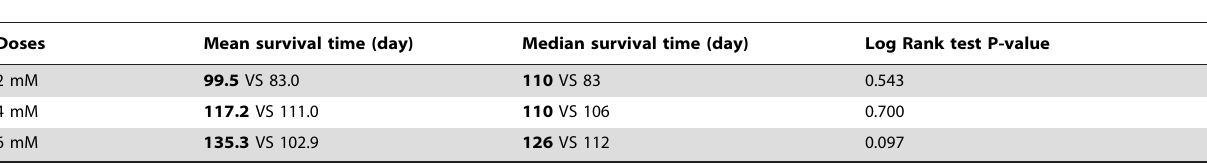
Table 2. Comparison of mean and median survival time of SMN mice injected with PMO(-10-34) or Scramble.